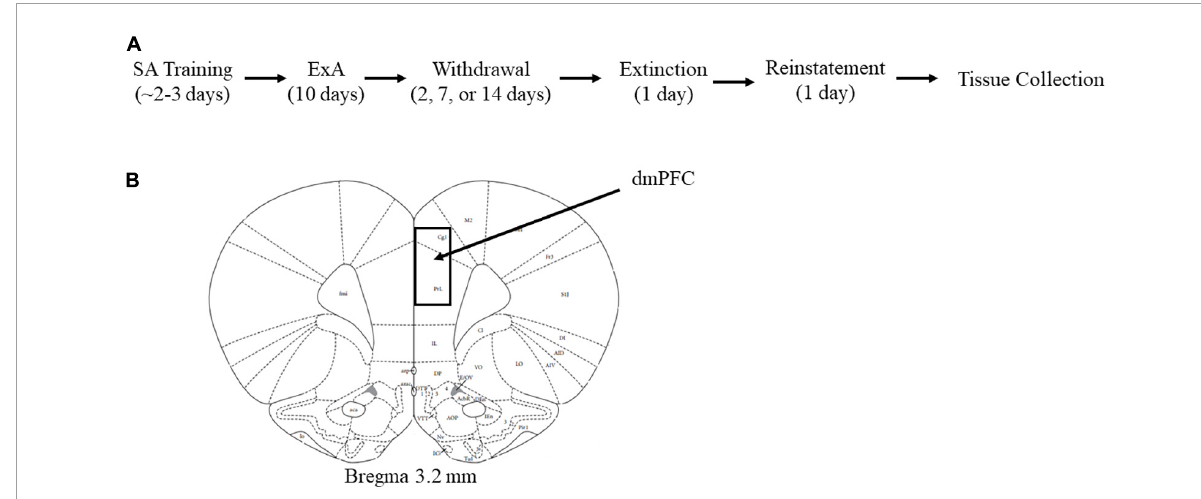
FIGURE1 Summary of experimental events and brain region dissected for the gene expression analyses. (A) Timeline of experimental events: Following self-administration training (SA), rats were given 24-h/day extended (ExA) access to cocaine (1.5 mg/kg/infusion) under a discrete trial procedure for 10 days (4 trials/h). After the last cocaine self-administration session, rats were assigned to an early ( n = 13 females, 10 males), intermediate ( n = 13 females, 10 males), or late ( n = 13 females, 10 males) withdrawal groups. Additional rats were given access to saline and assigned to an early ( n = 4 females, 5 males), intermediate ( n = 4 females, 4 males), or late ( n = 6 females, 2 males) withdrawal groups. Following the appropriate days of withdrawal, rats underwent extinction testing in a minimum of 6, 1-h sessions and then the next day reinstatement testing in a 1-h session. Tissue was collected immediately after the reinstatement session. (B) Schematic illustration of the brain region dissected for the dorsomedial prefrontal cortex